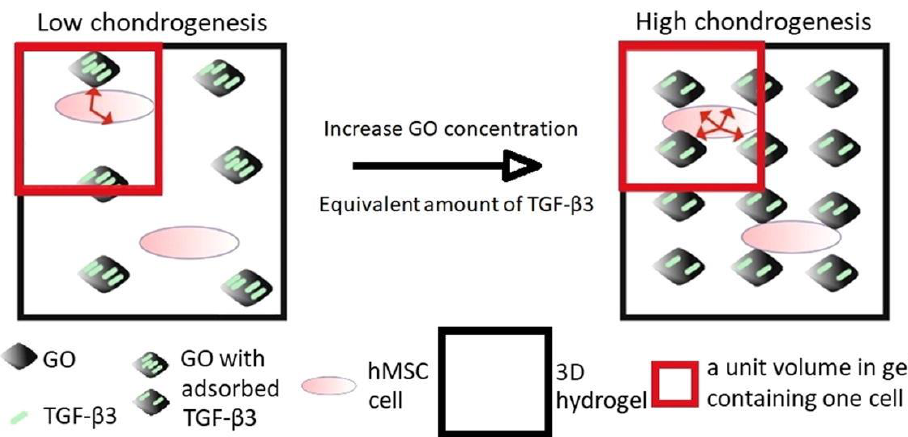
Figure 3. Demonstration of simultaneously incorporating both human mesenchymal stem cells (hMSCs) and GO (graphene oxide)-adsorbed growth factor TGFβ3 into a 3D scaffold, where GO- adsorbed TGFβ3 enhanced chondrogenic differentiation of hMSCs and cartilage-tissue synthesis This image is reprinted under a Creative Commons CC BY 4.0 license from [67].